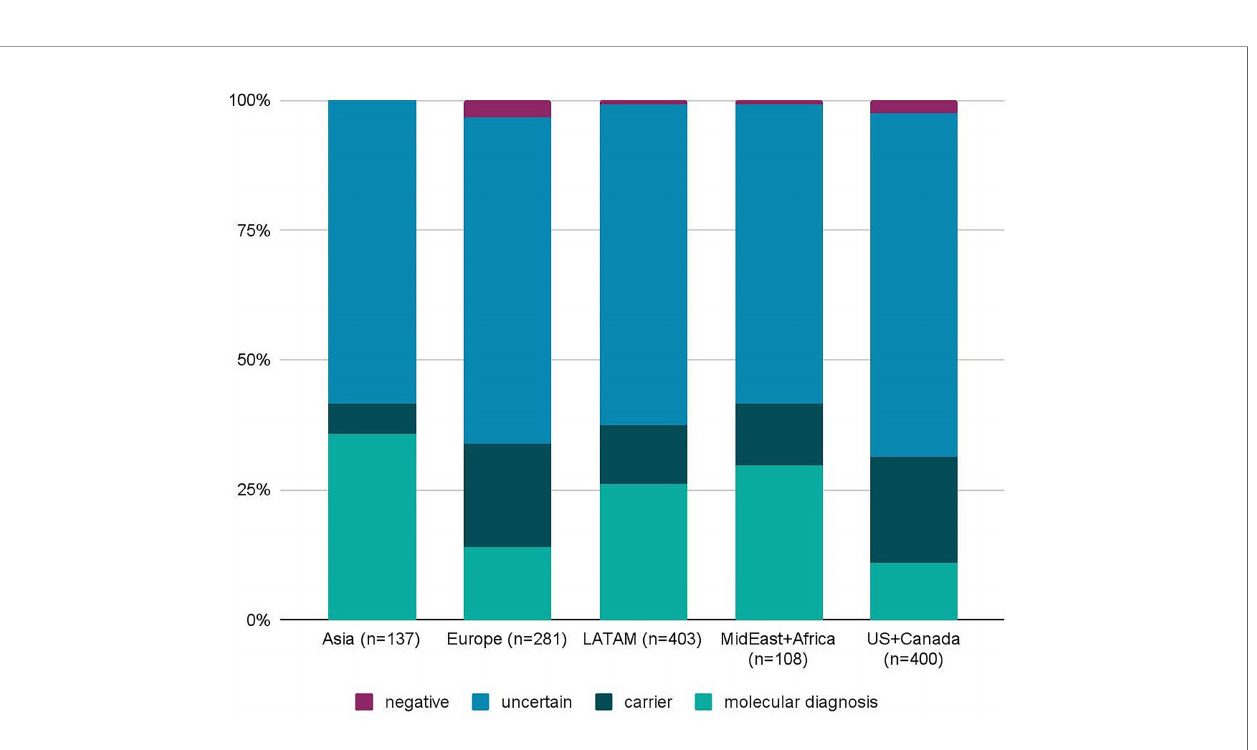
FIGURE 3 | Diagnostic yield of the Jeffrey ’ s Insights program by geographic region. The diagnostic yield was calculated for patients from Asia, Europe, Latin America (LATAM), the Middle East (MidEast) plus Africa, and the United States (US) and Canada. Regional diagnostic yields were calculated the same way as the global diagnostic yield. Two out of 4 patients from Australia and New Zealand received a molecular diagnosis. However, these were excluded from the graph due to the low number of samples. n=number of